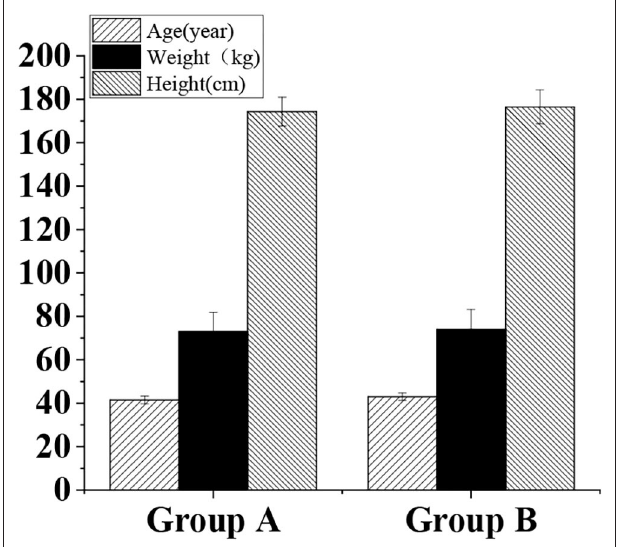
FIGURE 1 | The basic physical information of included